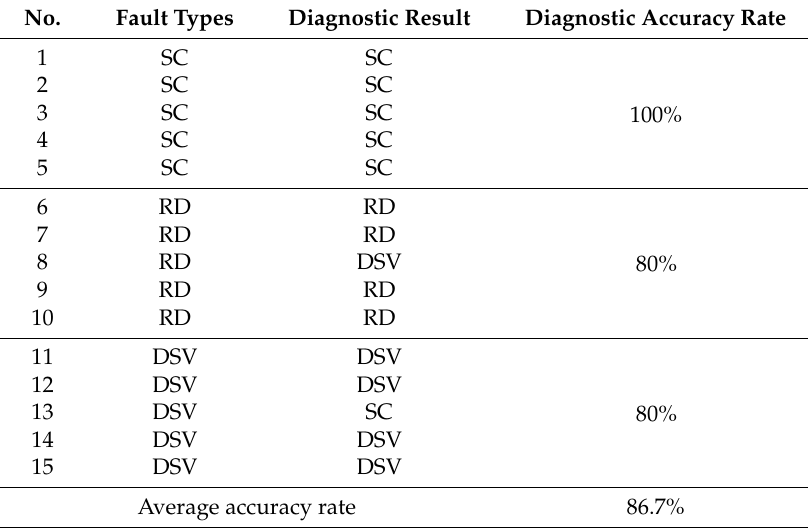
Table 4. Result of classifying a typical testing set using SVM (IRFV).